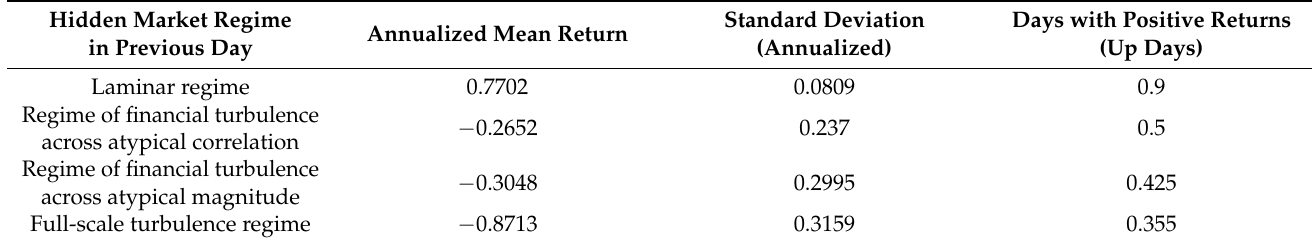
Table 15. Daily returns distribution for the S&P 500 index during switches among four Markov regimes in the COVID-19